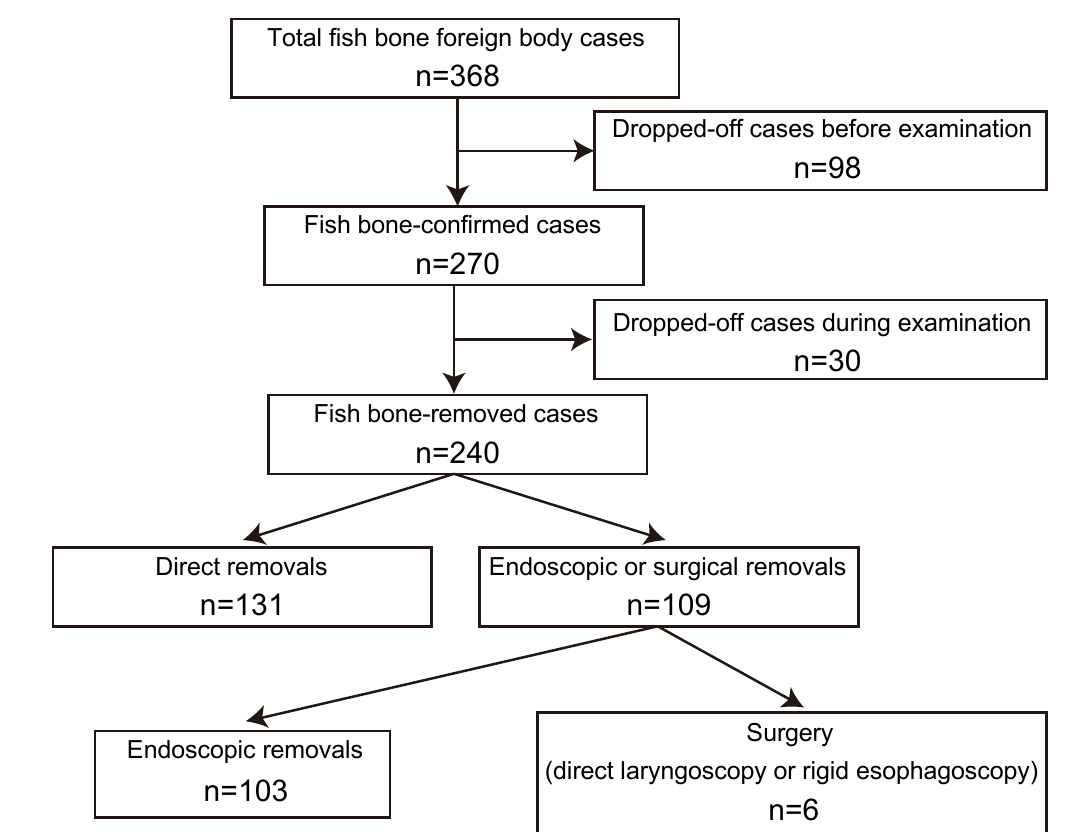
Fig 1. Patient enrolment and the treatment of fish-bone foreign